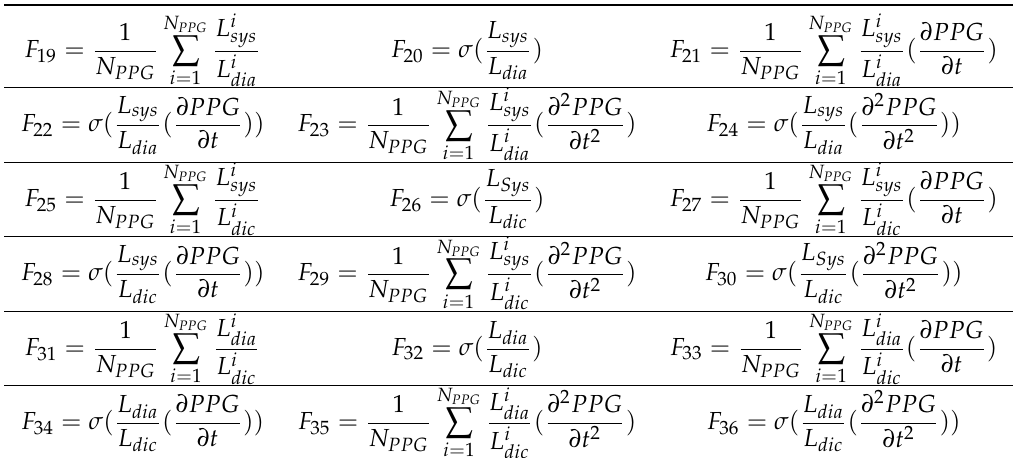
Table 2. Features from F 19 – F 36